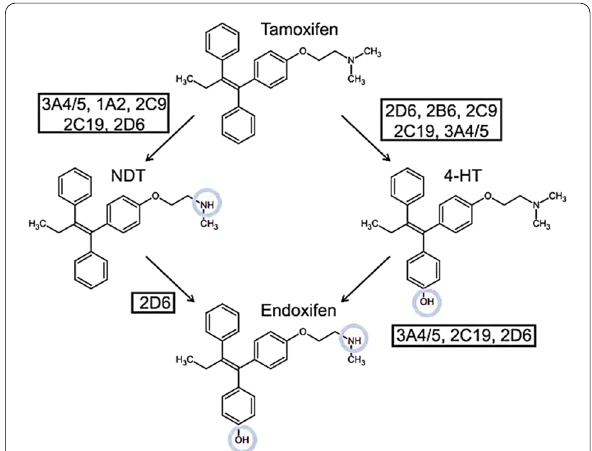
Fig. 1 Tamoxifen metabolism pathway in humans [16]. CYP 2D6 is the major isoform responsible for the formation of 4-hydroxytamoxifen and CYP3A4/5 is the major isoform responsible for the formation of N-desmethyltamoxifen, whereas the generation of Endoxifen is predominantly catalyzed by CYP2D6 . Other CYP isoforms, including CYP2C19 , CYP2C9 , and CYP2B6 , appear to play less important roles in Tamoxifen metabolism in vitro at therapeutically relevant